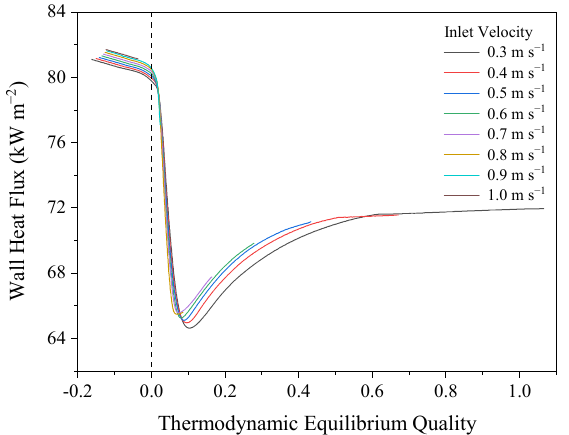
Figure 17. Wall heat flux vs. thermodynamic equilibrium quality at inlet velocities from 0.3 m · s − 1 to 1.0 m · s − 1 .